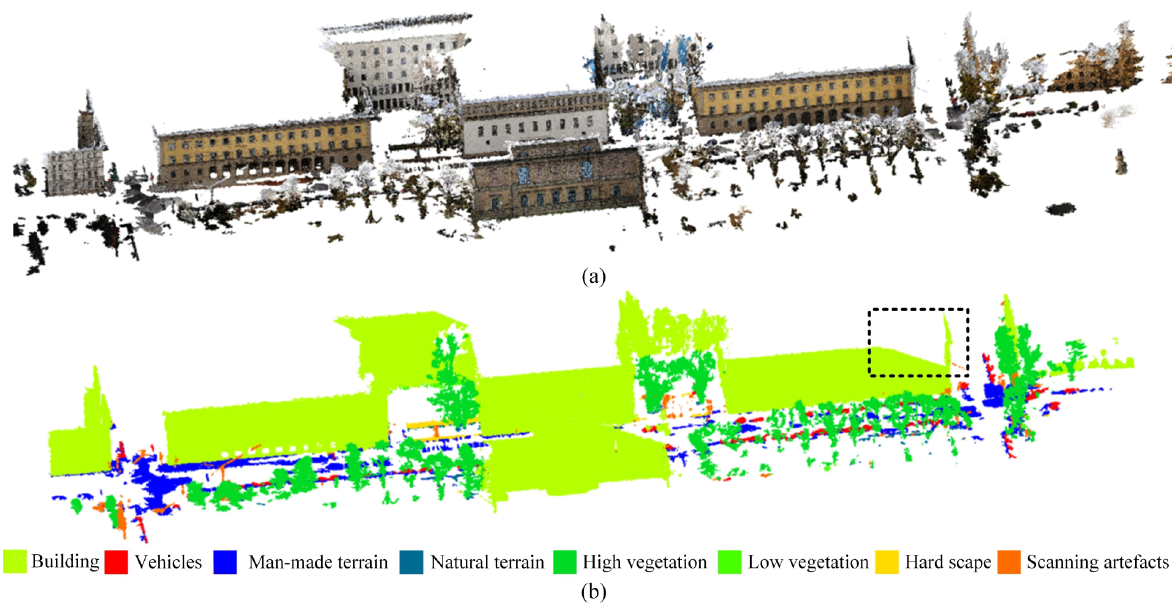
Figure 6. (a) Original testing point cloud and (b) Labeled testing point cloud.